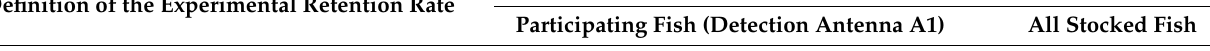
Table 3. Overview of the four different definitions of the experimental retention rate depending on the main parameter combinations without and with exclusion of initial effects (during the first hour of the experiments) and referring to either the number of participating fish (detection at antenna A1) or all stocked fish in the